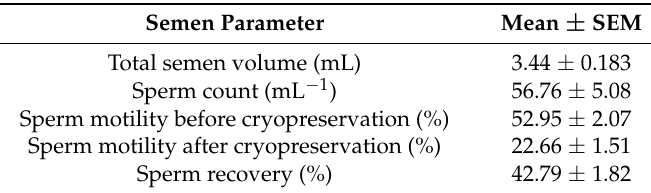
Table 1. The mean values of the semen parameters for all specimens ( n = 77). Values are means ± SEM (standard error of the